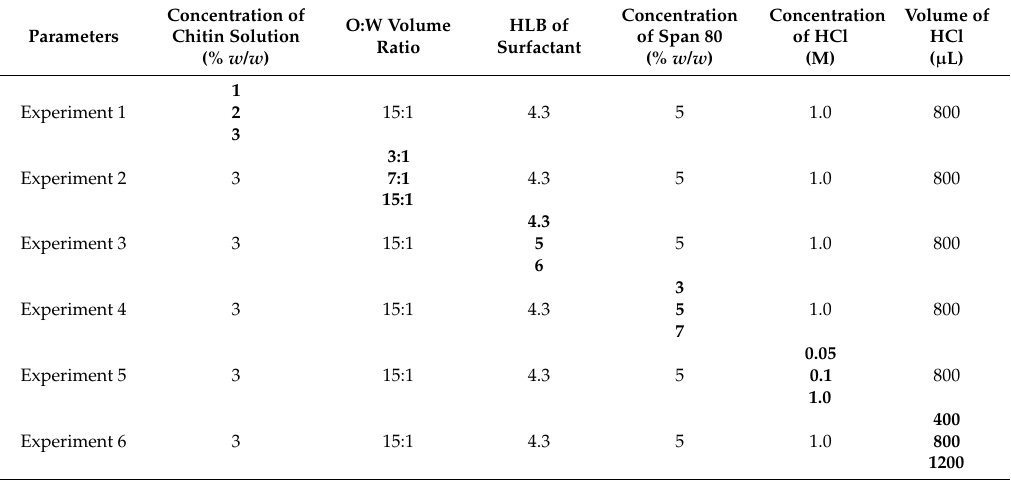
Table 1. Parameters in preparation of chitin